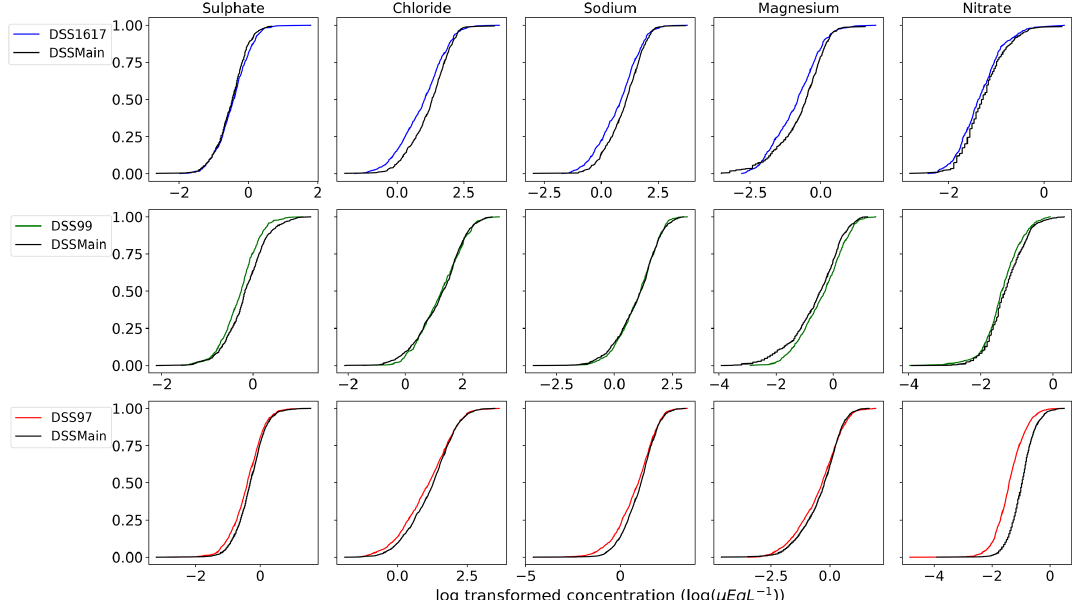
Figure B2. Empirical cumulative distribution functions of the log-transformed concentration data for each trace chemistry species. Epochs from DSS1617, DSS99 and DSS97 are each compared against epochs from the DSSMain core with similar but not identical snow accumu- lation rates. Epochs are determined by the change-point analysis on the CUSUM snow